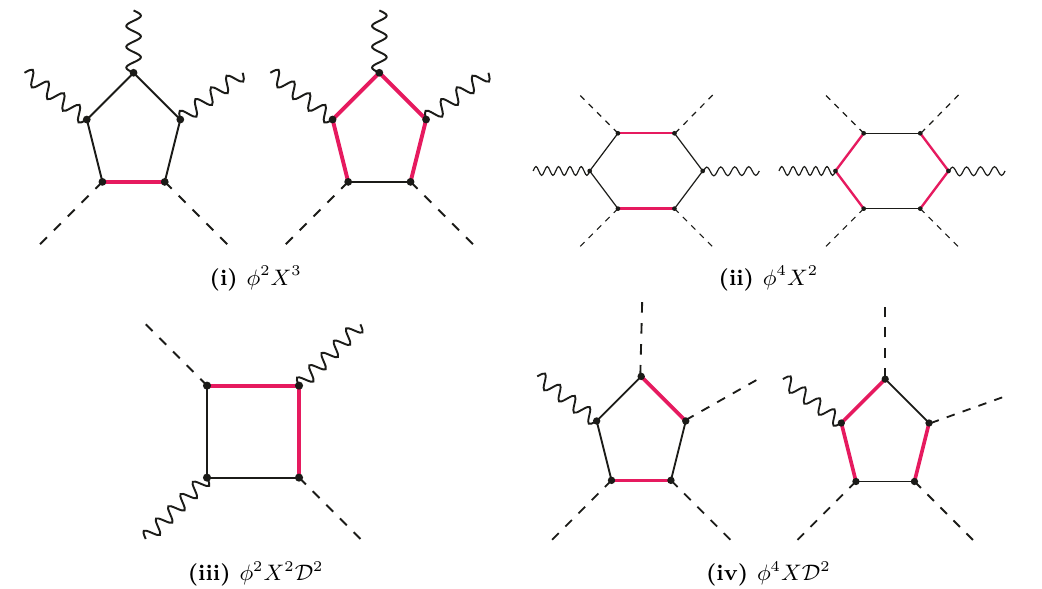
Figure 9. Schematic diagrams revealing light-heavy fermion mixing incorporated within (i) φ 2 X 3 , (ii) φ 4 X 2 , (iii) φ 2 X 2 D 2 , and (iv) φ 4 X D 2 classes of SMEFT